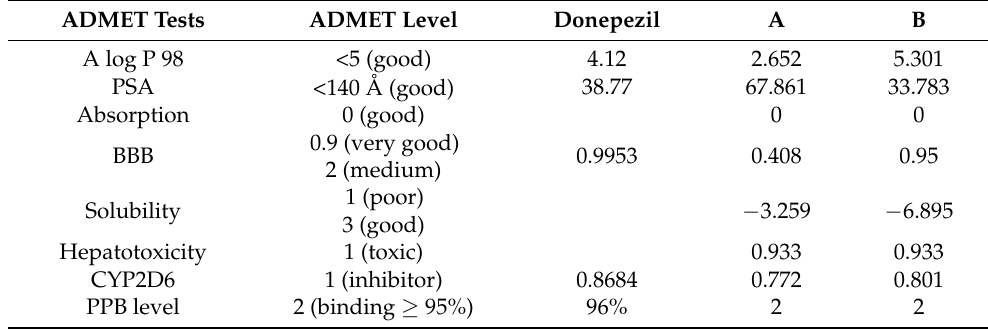
Table 6. ADMET prediction descriptors calculated by Discovery Studio